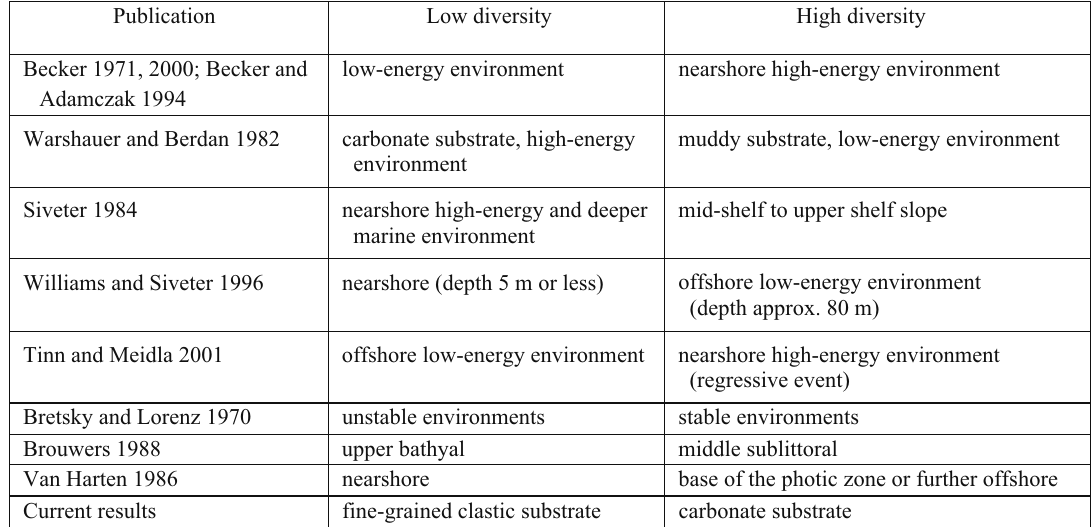
Table 7. Previous studies of ostracod carapace morphology in relation to ecological